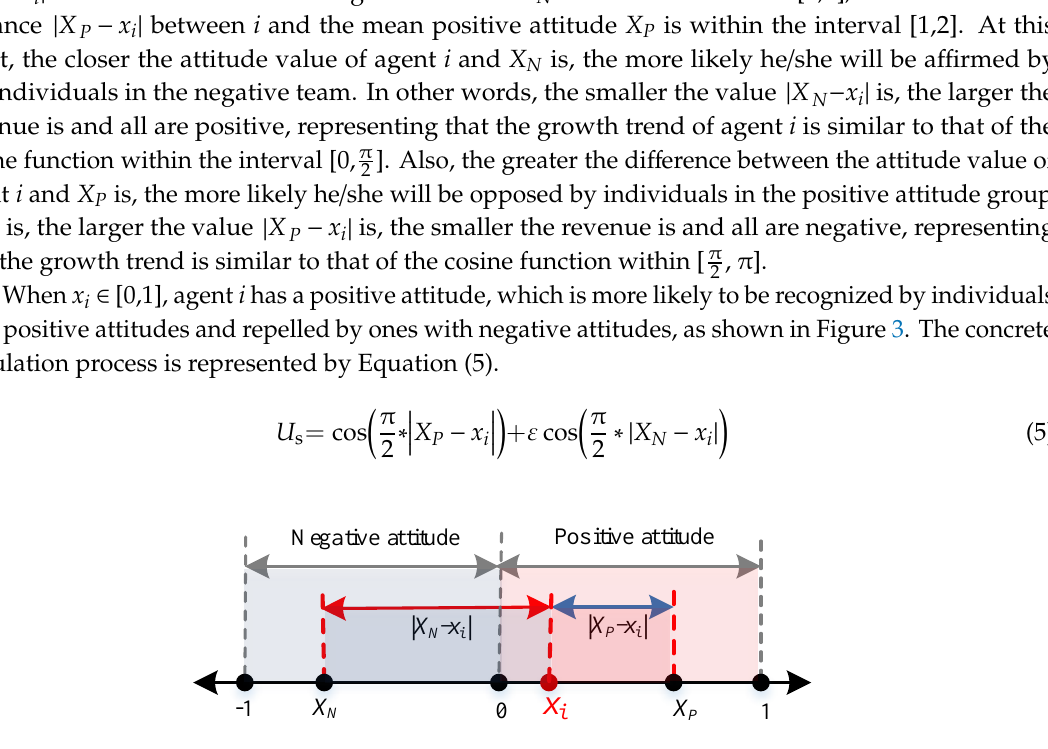
Figure 3. Calculation diagram of social mainstream revenue with positive attitude.